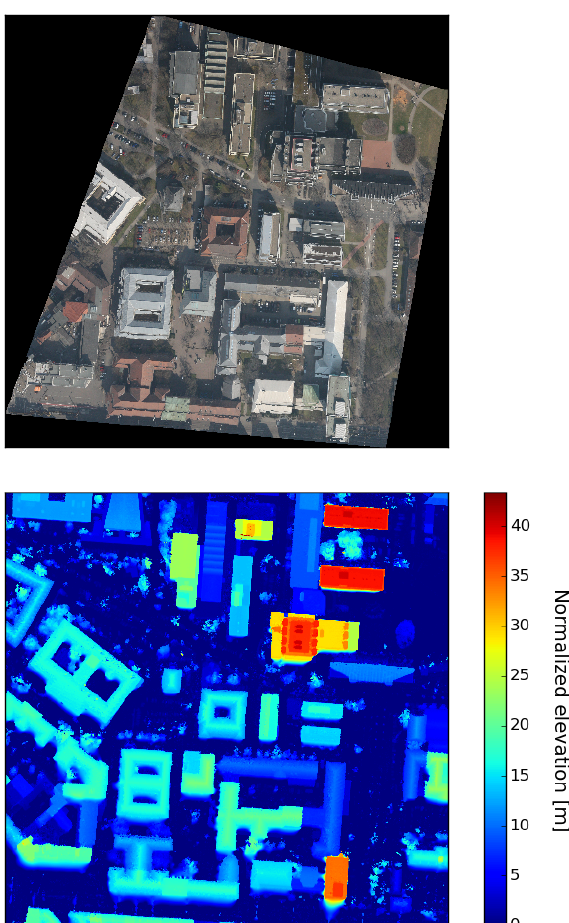
Figure 5: Input data: RGB image (above) and nDSM (below)